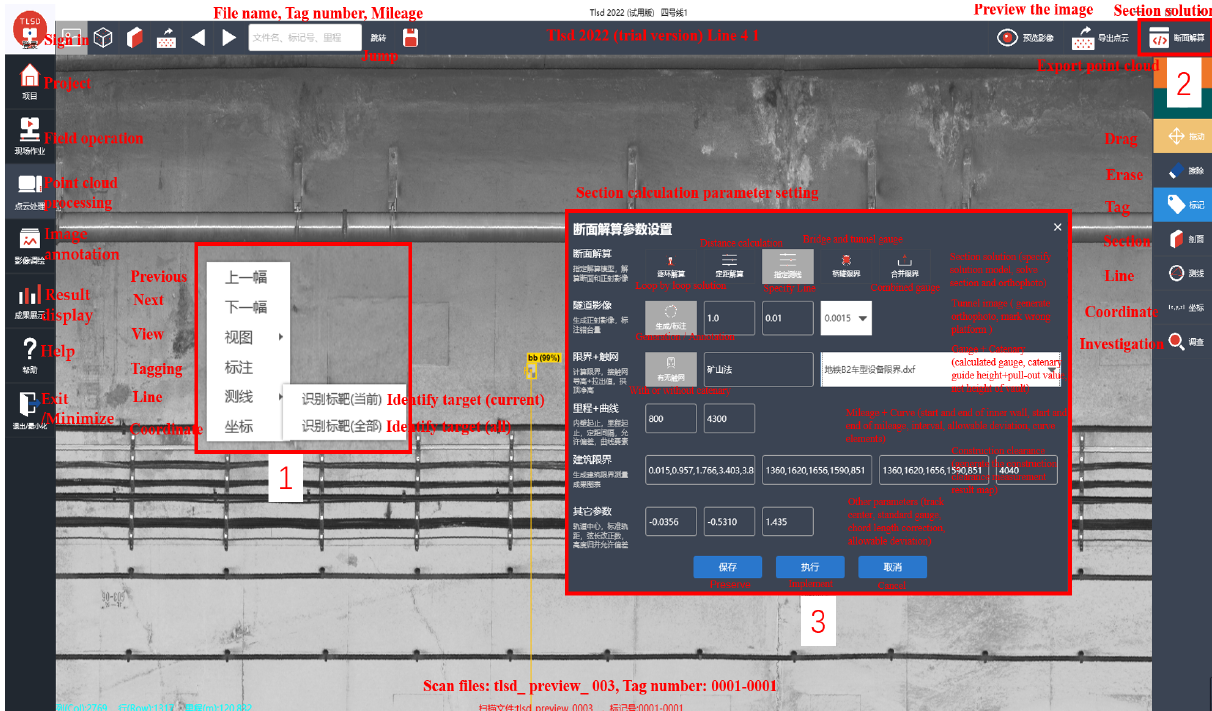
Figure 15. Engineering application interface.